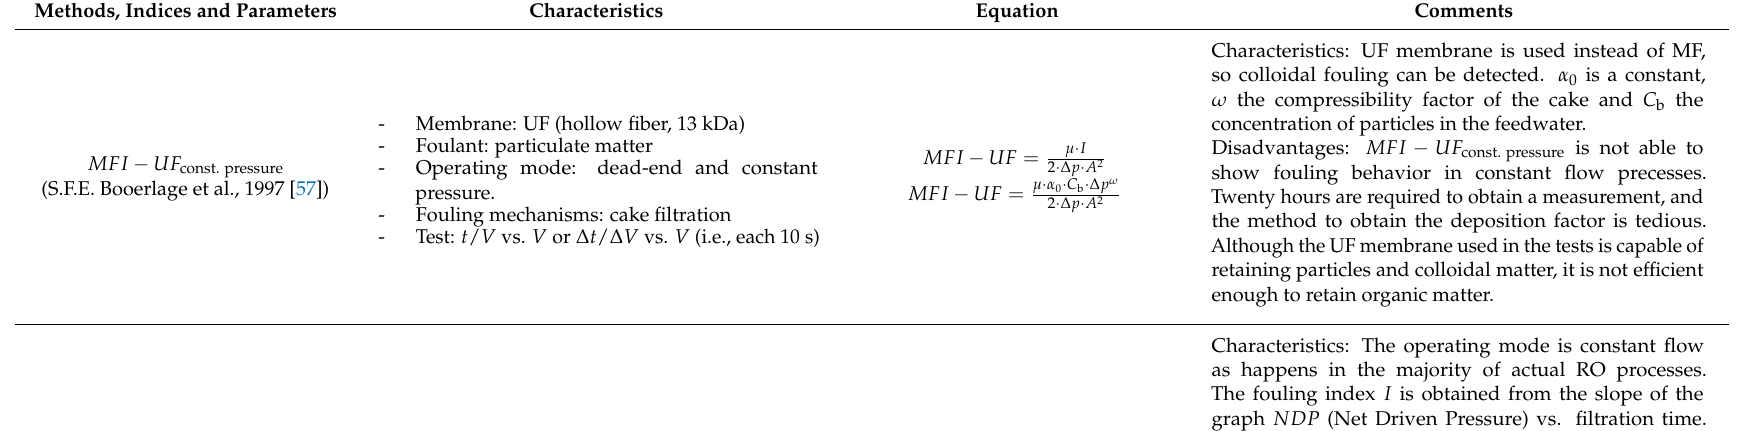
Methods, Indices and Parameters Characteristics Equation